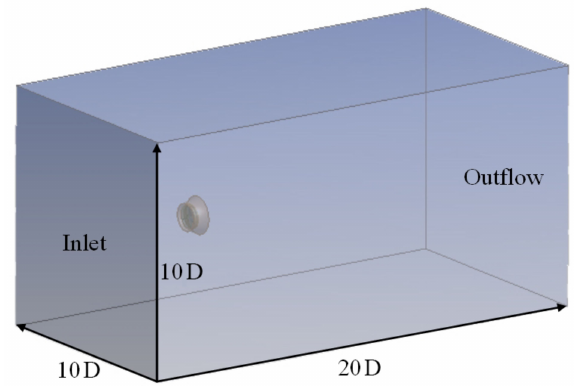
Figure 4. Calculation